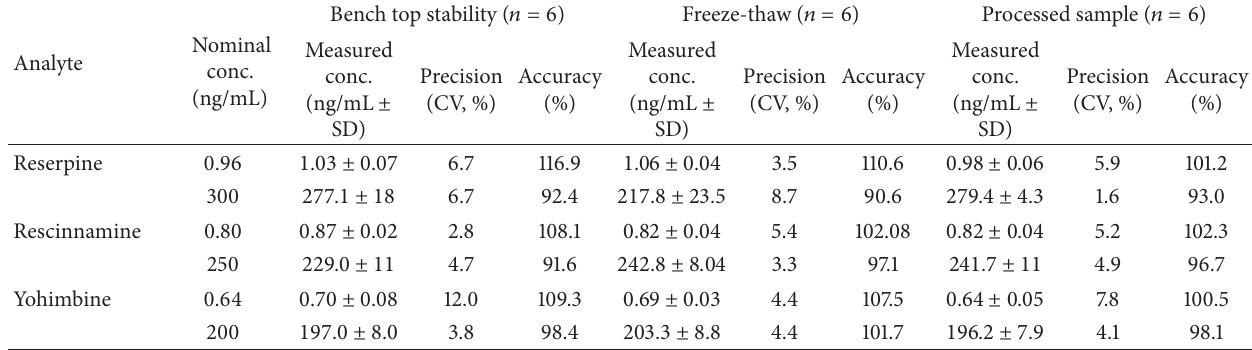
Table 2: Stability data of reserpine, rescinnamine and yohimbine in plasma.